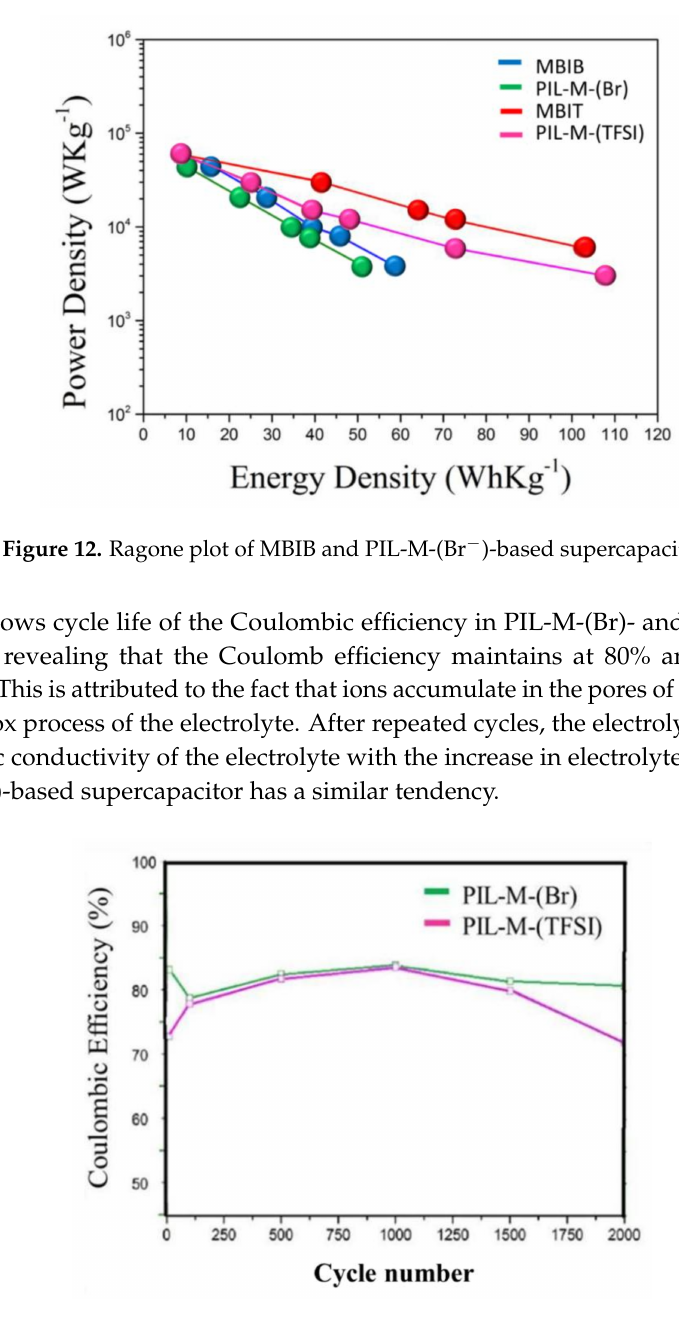
Figure 13. Cycle life of PIL-Il blend-based